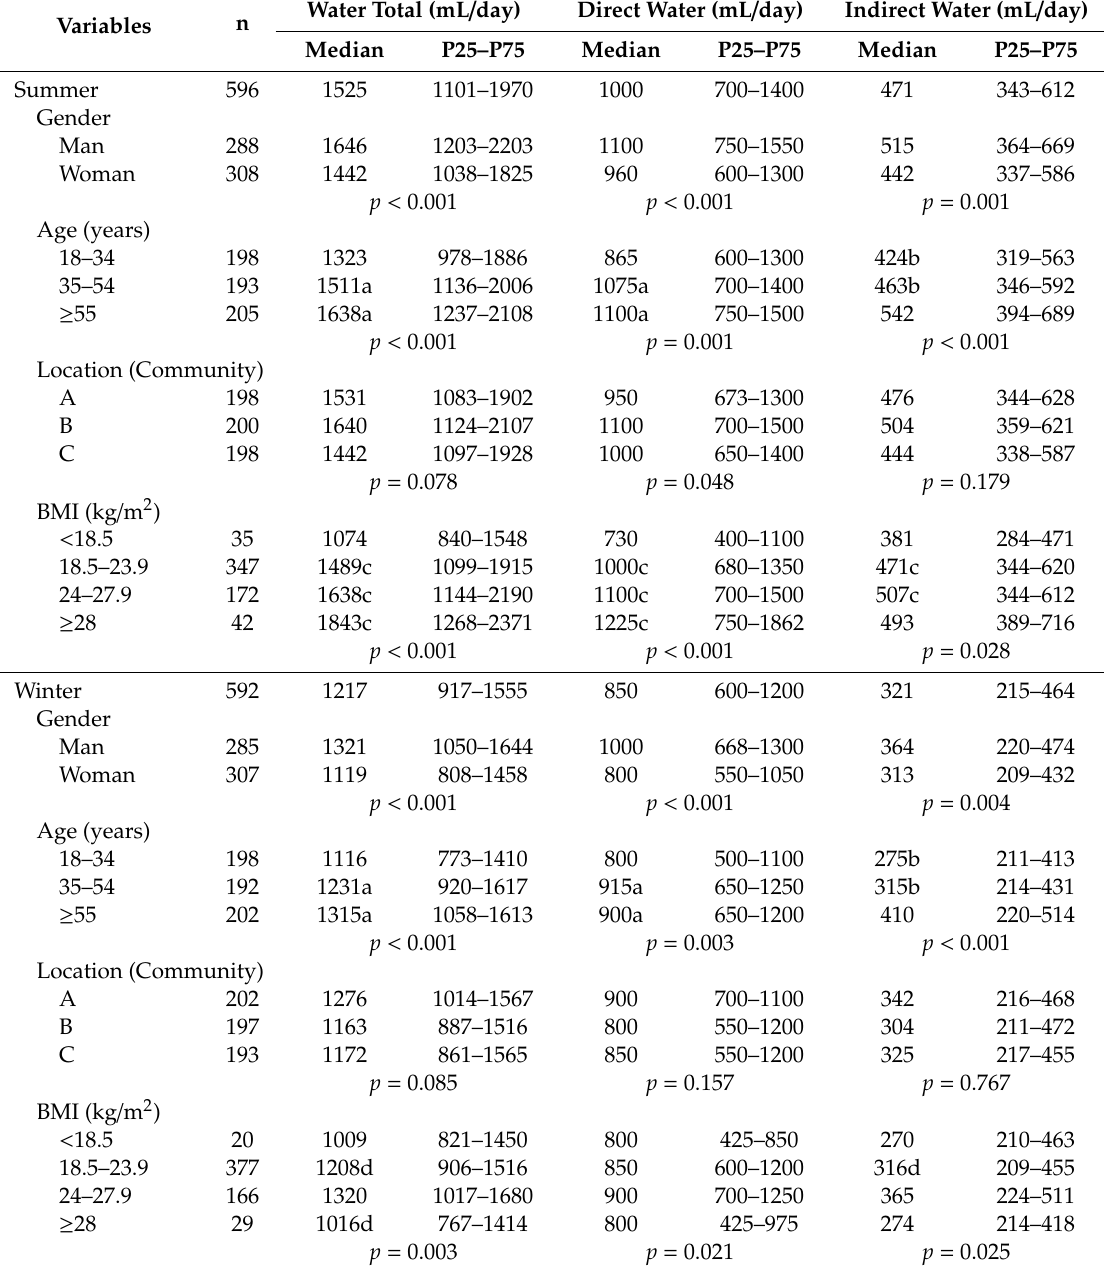
Table 2. Water consumption of the adults according to demographic variables in summer and